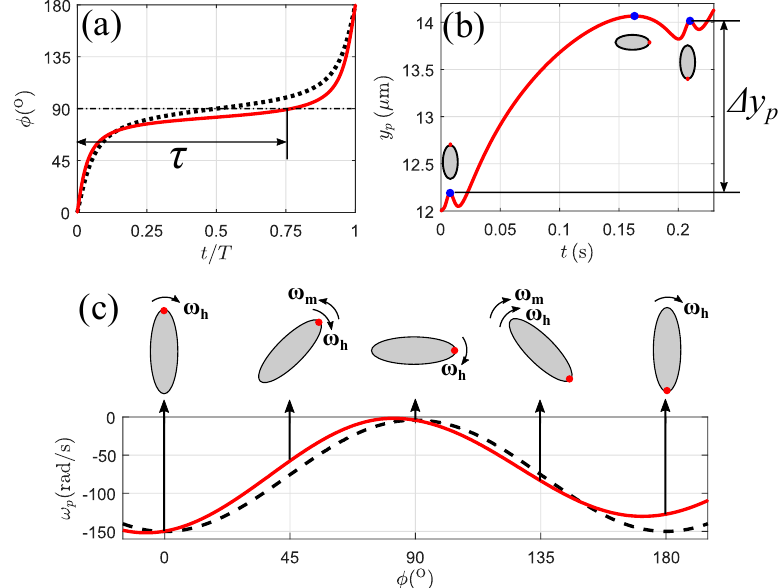
Figure 6. Transport of the particle when the magnetic field is applied perpendicular to the flow direction, i.e., α = 0 ◦ . The particle ( AR = 4) is initially located at y p 0 = 12 µ m. ( a ) the orientation angle, φ versus dimensionless time t / T . A dimensionless time parameter τ is defined as the ratio of the time for the particle rotating from 0 ◦ to 90 ◦ to the period of rotation, T ; ( b ) the particle–wall separation distance, y p 0 as a function of time ( H 0 = 3000 A/m, α = 0 ◦ ). ∆ y p denotes the net lateral migration of the particle over one period; ( c ) the rotational velocity ω p versus φ : H 0 = 0 A/m (dash line), and 3000 A/m (solid line). The symmetry of particle rotational velocity ω p about φ = 90 ◦ is broken, and τ >